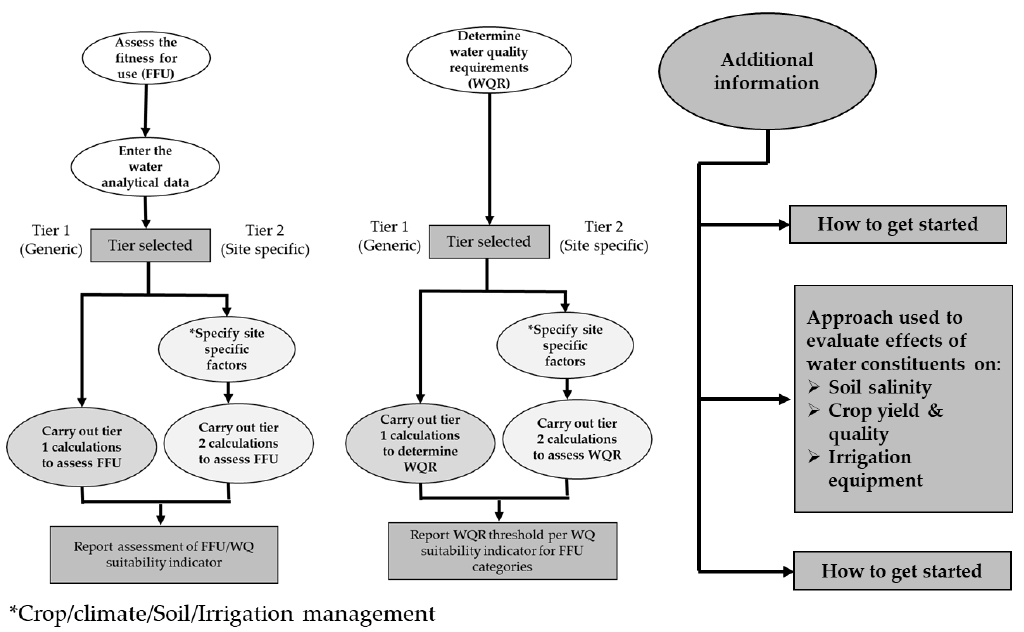
Figure 1. The structure of the risk-based, site-specific Decision Support System (DSS). Adapted and modified from du Plessis et al. [12].